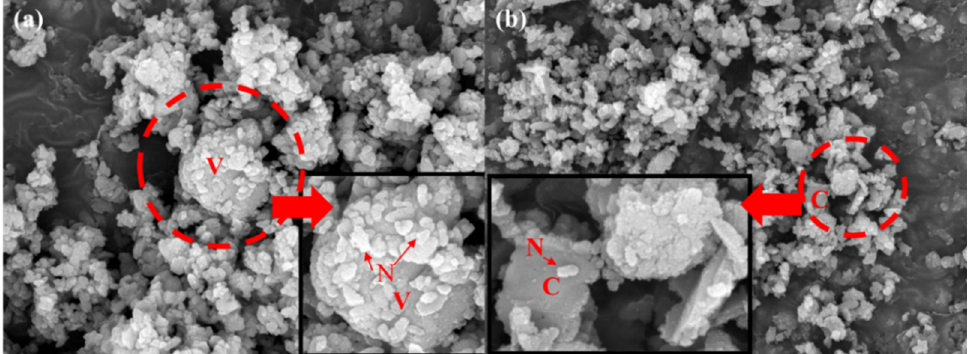
Figure 4. Verification of the precipitates in 5 wt % amines by XRD, except for MEA solution. The formed precipitate was not washed in water. The results were like those in Figure 3a, because the formed sodium chloride concentration was higher than that of the other precipitates: ( a ) aqueous CO 2 with 5 wt % DEA solution with concentrated seawater and ( b ) aqueous CO 2 with 5 wt % MDEA solution with concentrated seawater. (N: NaCl, C: calcite, V: vaterite, A: aragonite).